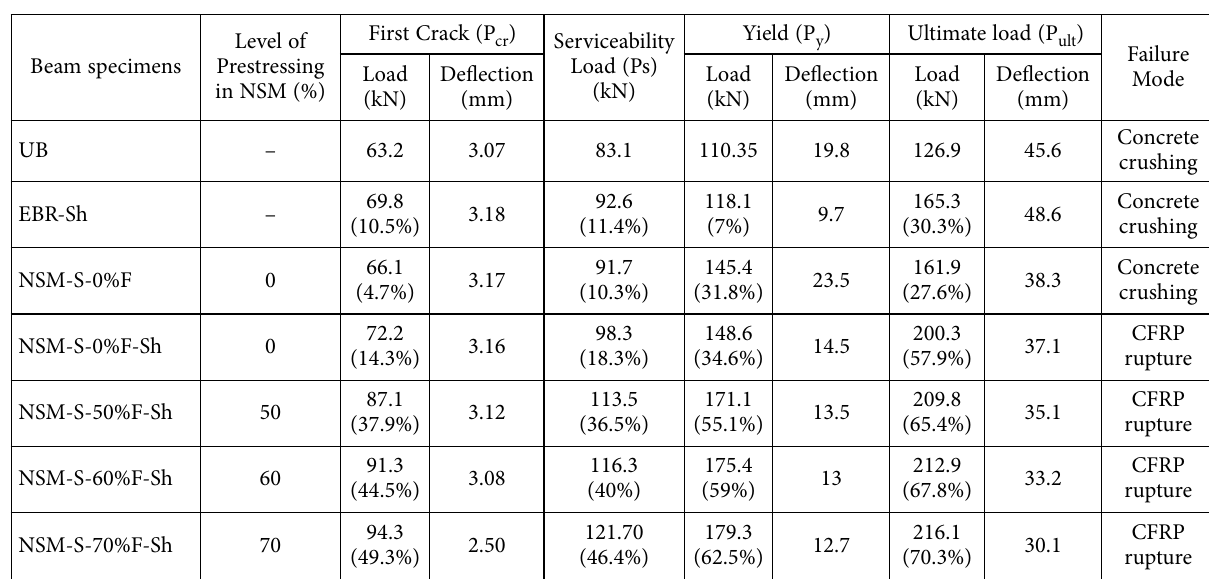
Table 2. Test results for load and